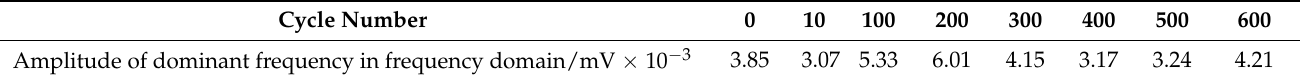
Table 4. Amplitude information of acoustic emission signals of Group B batteries during